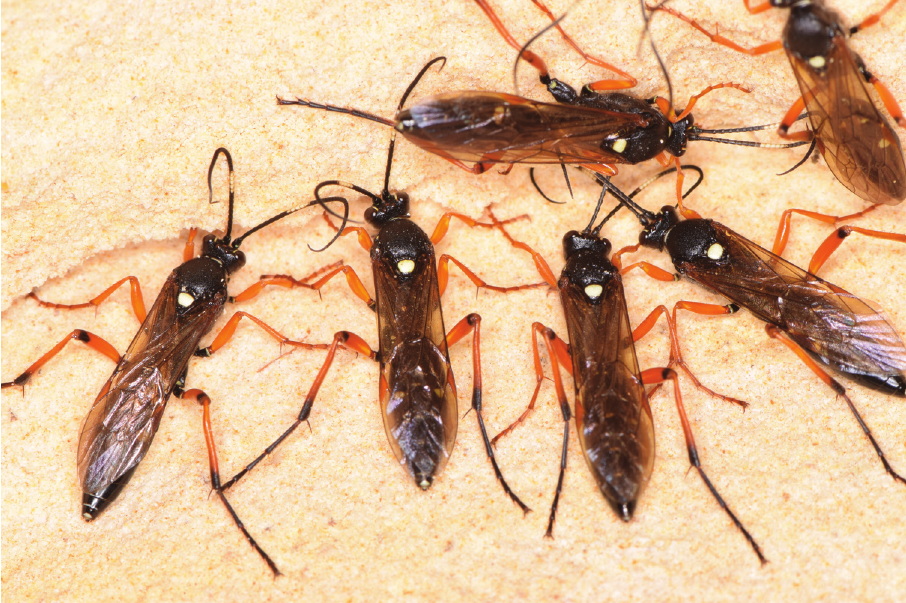
Figure 1. Females of Diphyus quadripunctorius (Müller, 1776) hibernating in a limestone cave in the Netherlands, Maastricht (Sint-Pietersberg), 4 December 2019. Willem